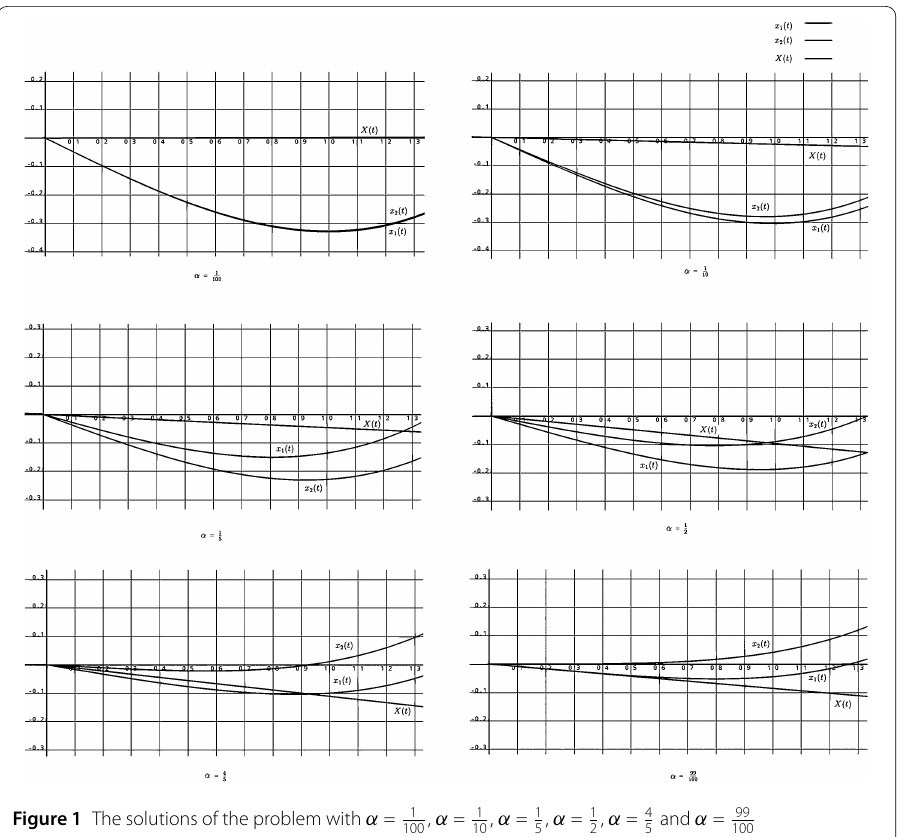
, α = 1 , α = 1 , α = 1 , α = 4 and α = 99 100 10 5 2 5